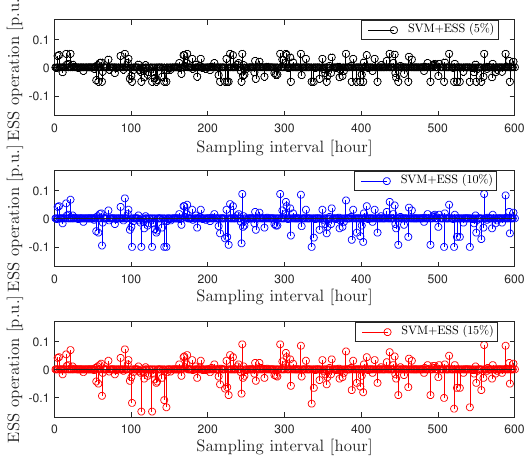
Figure 8. Operation of the ESS for the ANN scheme with varying time intervals of day time (Tolerance limit = 5%).